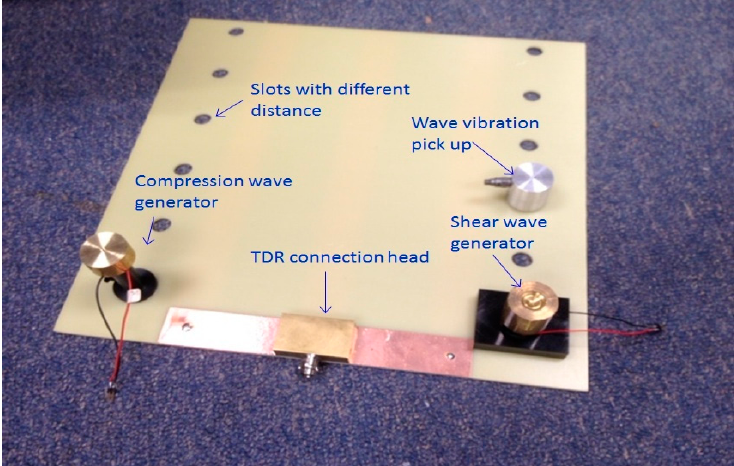
Figure 13. Probe combined with Piezoelectric Stack.